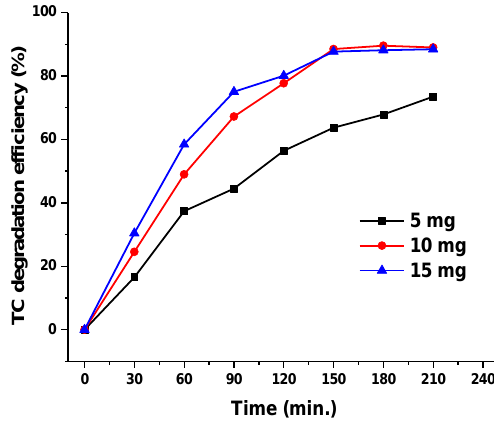
Figure 4. Degradation efficiency of TC (%) vs irradiation time (min) curves of 20 mL of TC solutions (30 mg/L) obtained respectively in presence of 5, 10 and 15 mg of ZnO/γ-Fe 2 O 3 composite catalyst.